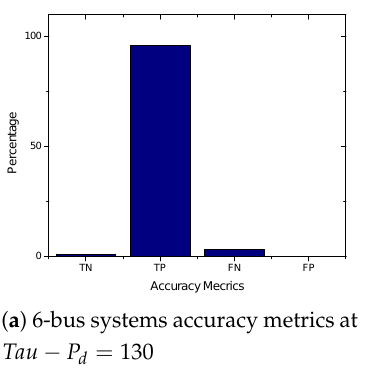
Figure 13. 6-bus and 9-bus systems accuracy metrics.